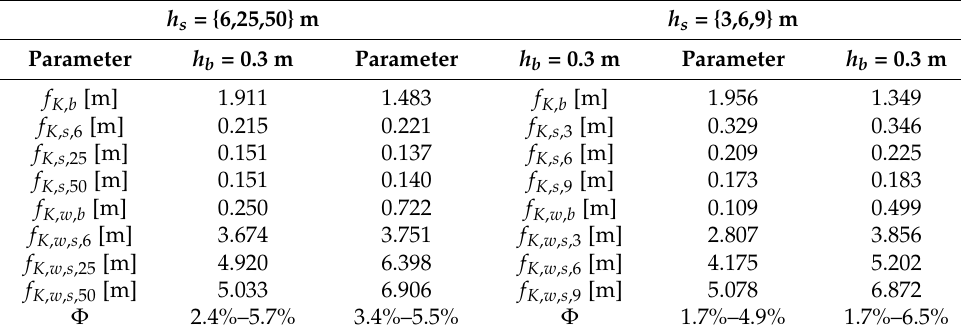
Table 2. Optimum values for the static case in combined